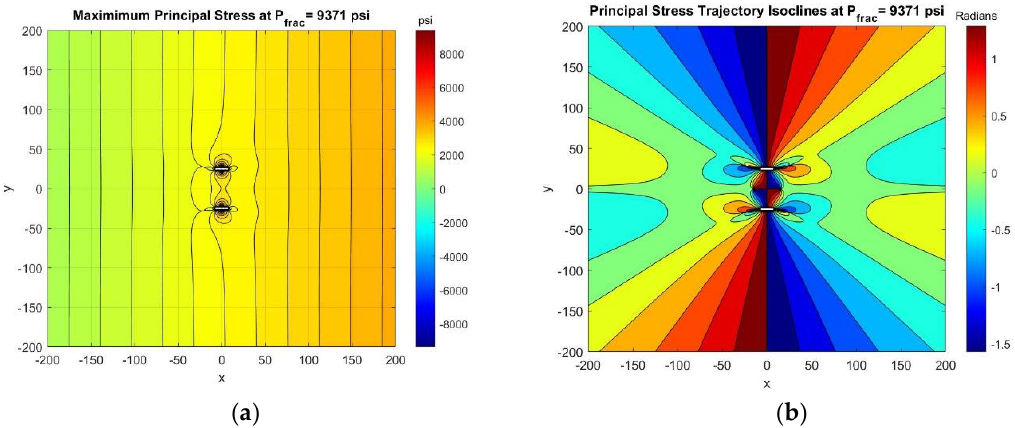
Figure 12. TLSM model results for the second successive hydraulic fractures showing ( a ) maximum principal stress, and ( b ) principal stress trajectory isoclines at t = 1.151 min. TLSM results were generated in 1.151 s including post-processing.